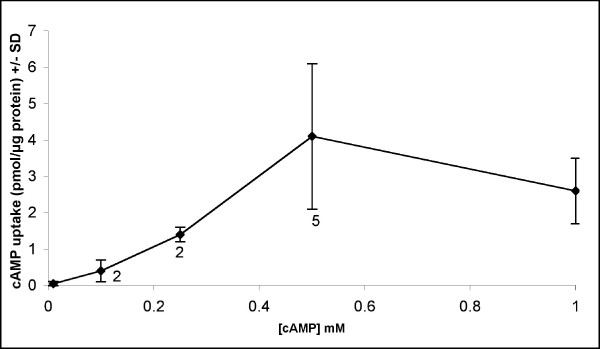
cAMP uptake in isolated RPE. Uptake of cAMP by isolated RPE following 30 min treatment with varying concentrations of exogenous cAMP. n = 4 except where noted.